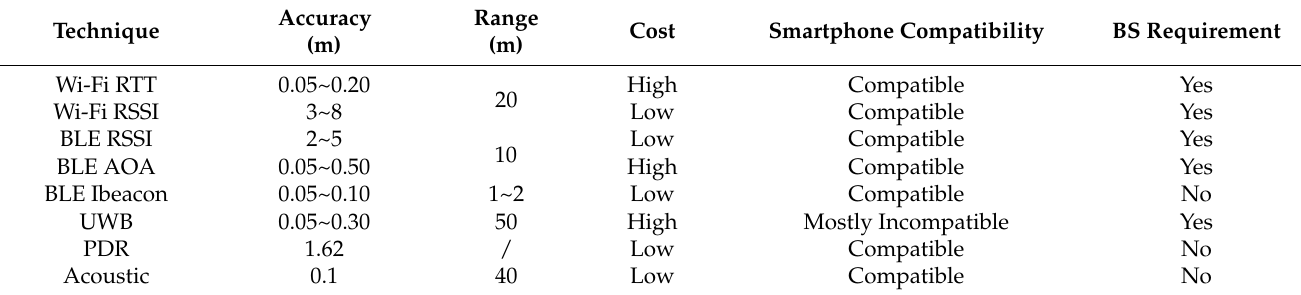
Table 1. The comparison of different techniques.